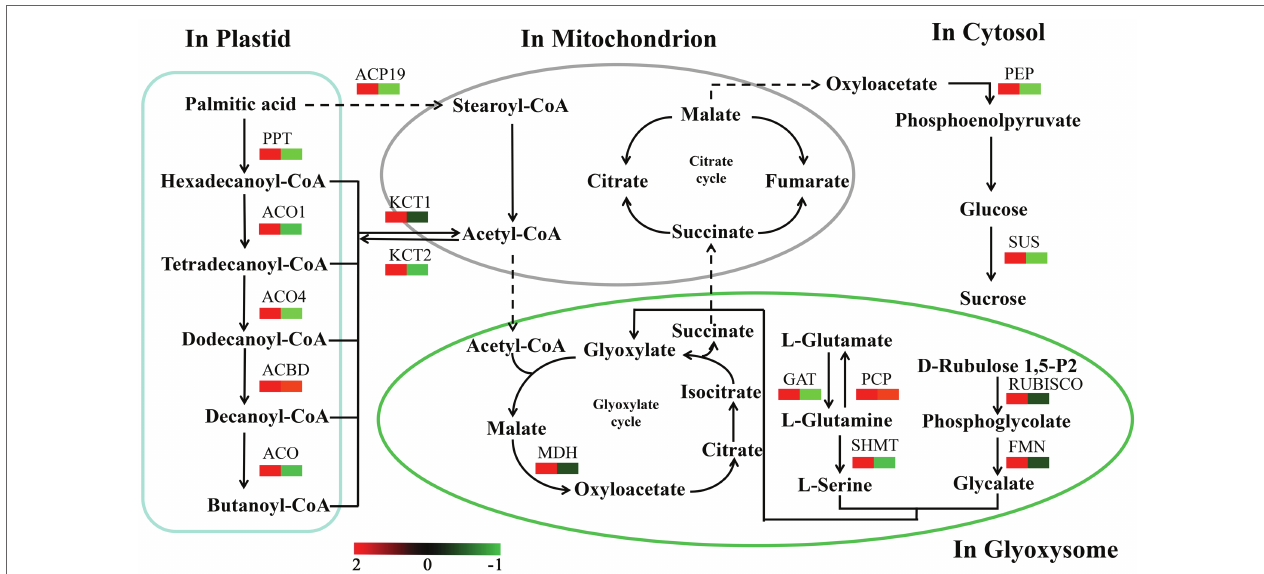
FIGURE 8 | Changes in quantified proteins associated with the abundance of key enzymes during the different stages of pollen development in O. longistaminata (left box: Ls-8.5 mm/Ls-6 mm, right box: Ls-6 mm/Ls-4